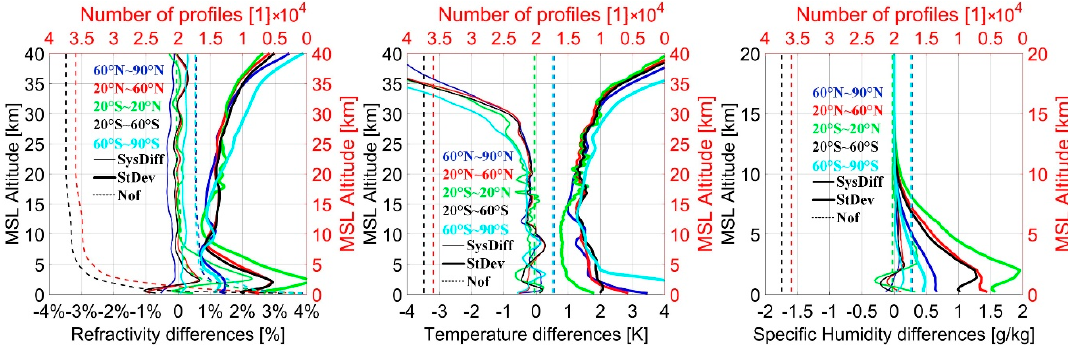
Figure 6. Systematic differences and standard deviations of FY-3C refractivity, temperature, and specific humidity profiles for the latitudinal bands of 60°N–90°N, 20°N–60°N, 20°S–20°N, 20°S–60°S, 60°S–90°S. Statistics are obtained by considering the FY-3C profiles in 2017. Dashed lines indicate the number of profiles (Nof) used for the corresponding latitudinal band.